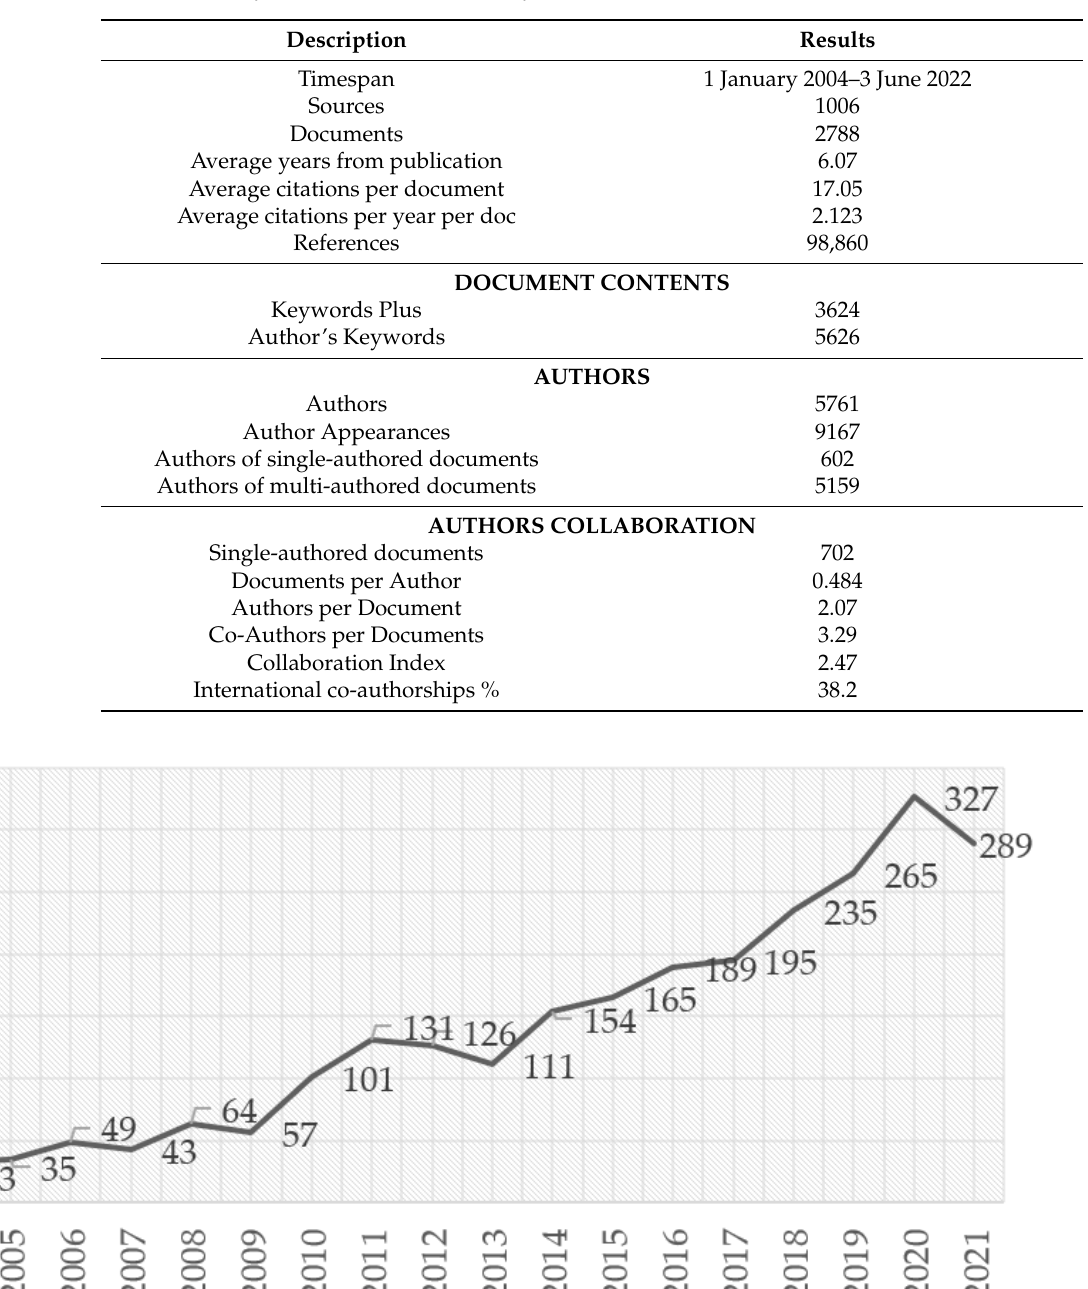
Table 1. Primary information and summary of the dataset.